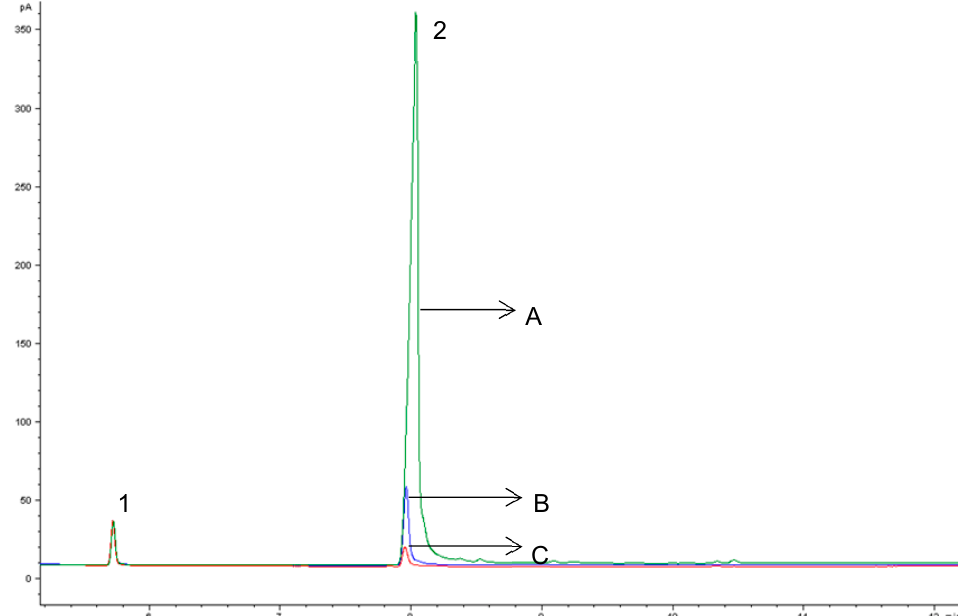
Figure 4. Comparison of gas chromatographic profiles of cholesterol in duck liver pâté from the control (A) and duck liver pâté treated with β -CD (B) and the precipitated β -CD–cholesterol complex separated by centrifugation (C). Peak identification: 1 = cholestane, 2 = cholesterol.